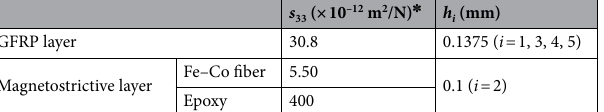
Table 1. Material properties. ✽ Here, we have dropped the superscripts G, f, and m.